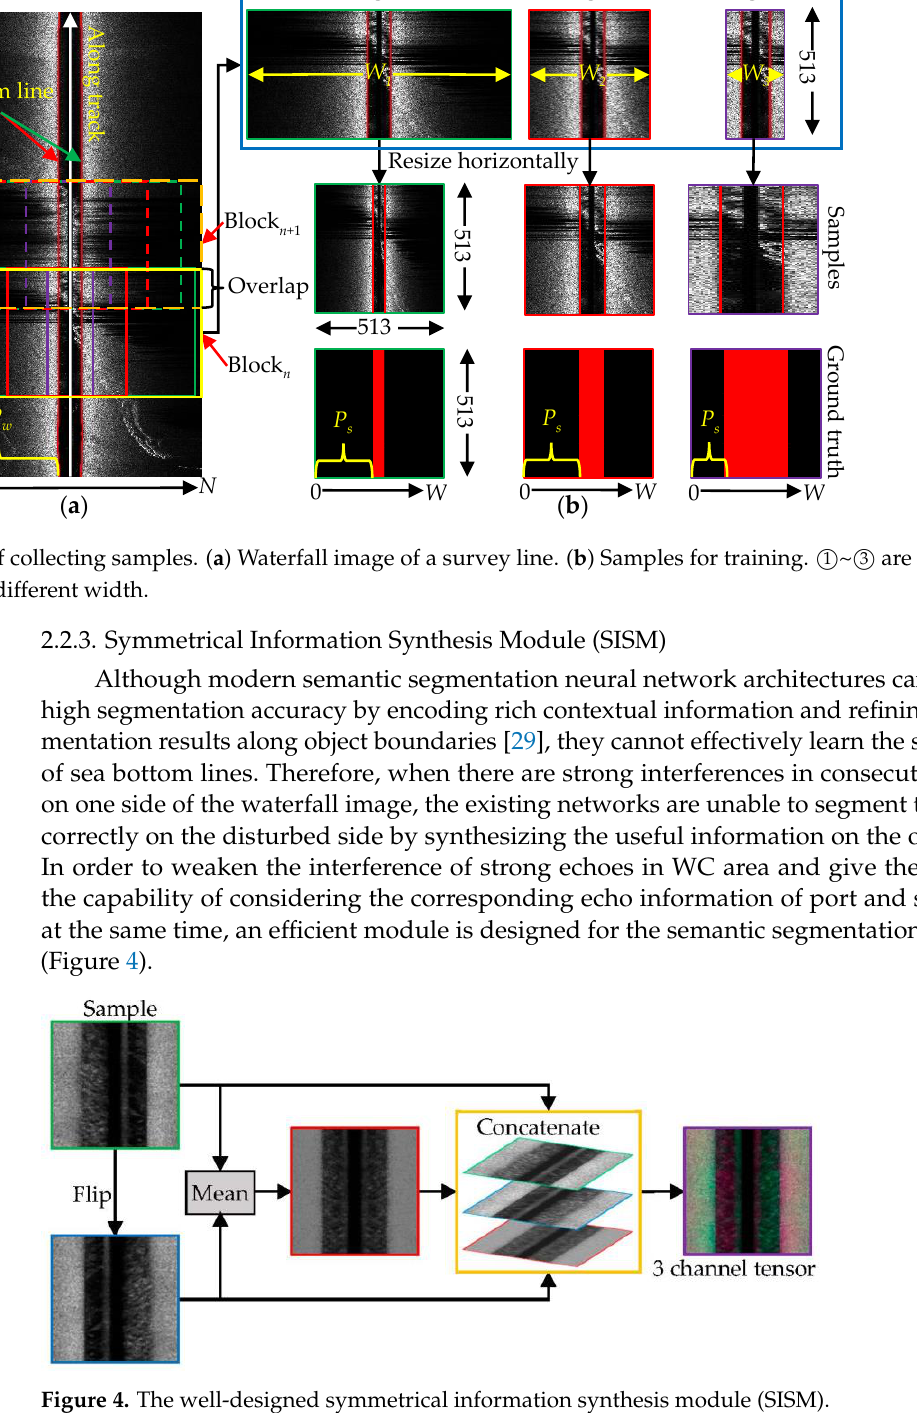
Figure 4. The well-designed symmetrical information synthesis module (SISM).